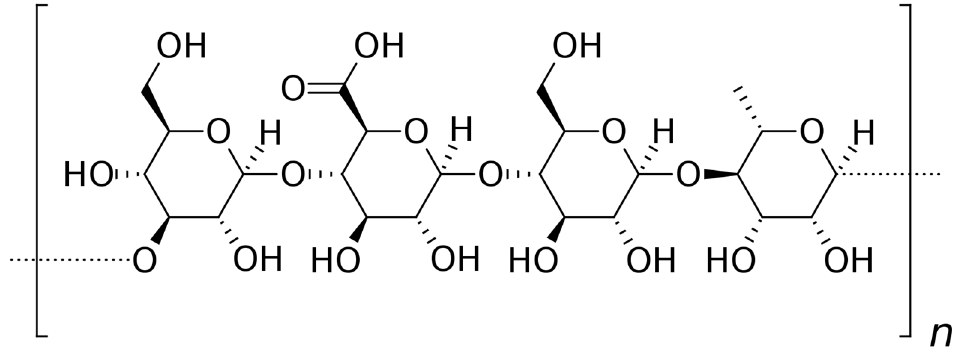
Figure 10. Structure of gellan gum.